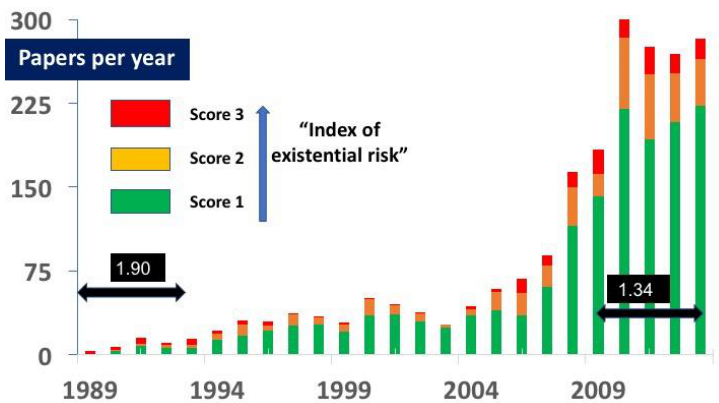
Figure 1. Number of papers in each category. Since 1989 the number of papers concerning climate change and health has expanded considerably, particularly since 2008. As this article did not review the entire literature, the actual number of papers published, even in English, is more than shown. The average score of these papers declined from 1.9 in the first quintile to 1.34 in the final five years.